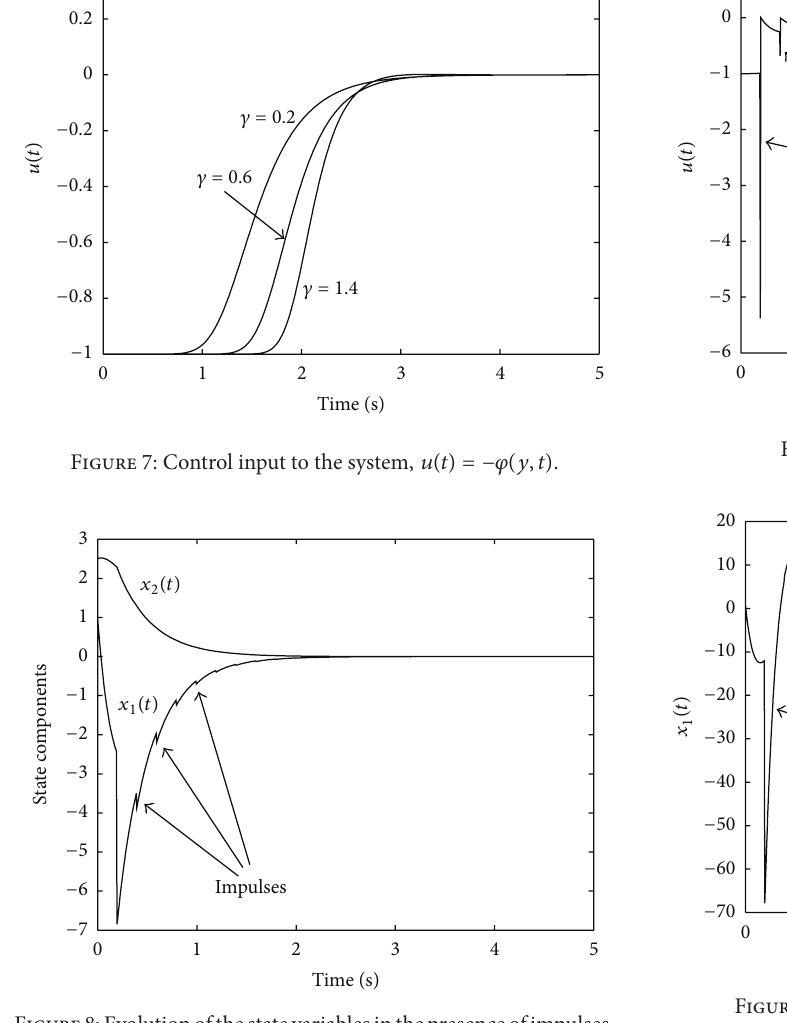
Figure8:Evolutionofthestatevariablesinthepresenceofimpulses.